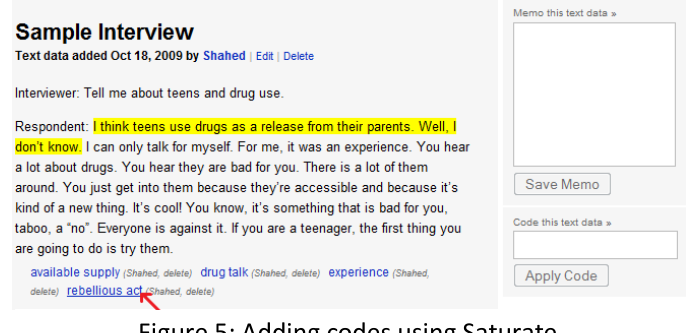
Figure 5: Adding codes using